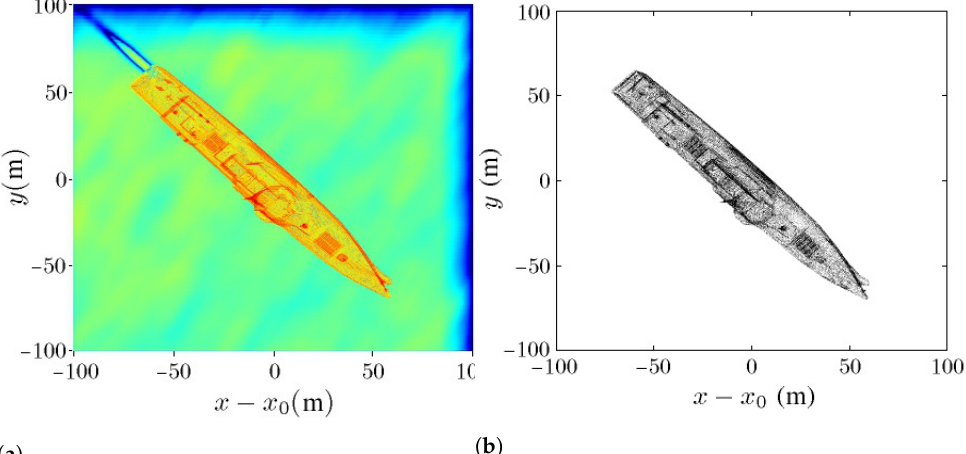
Figure 15. ( a ) Acquired image of Type 055 destroyer, in scale of (40, 90) dB and ( b ) scan image of 3D model.